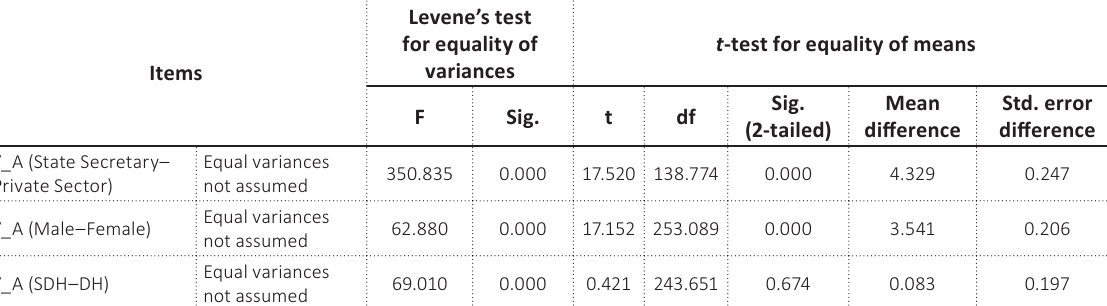
Table 5. Independent samples test